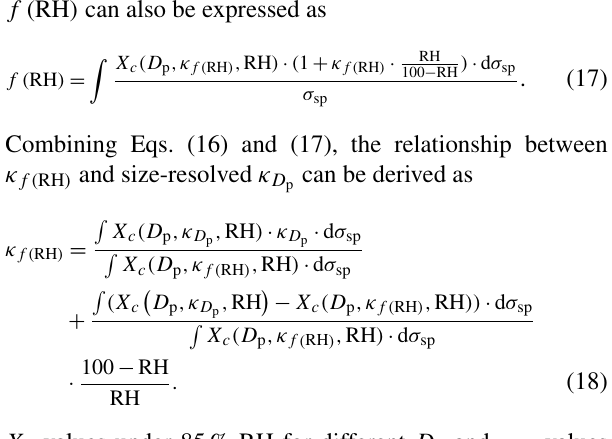
Figure 3. Simulated values of X c under 85% RH for different D p and κ D values. Black solid and dashed lines are two assumed size- p resolved κ D p